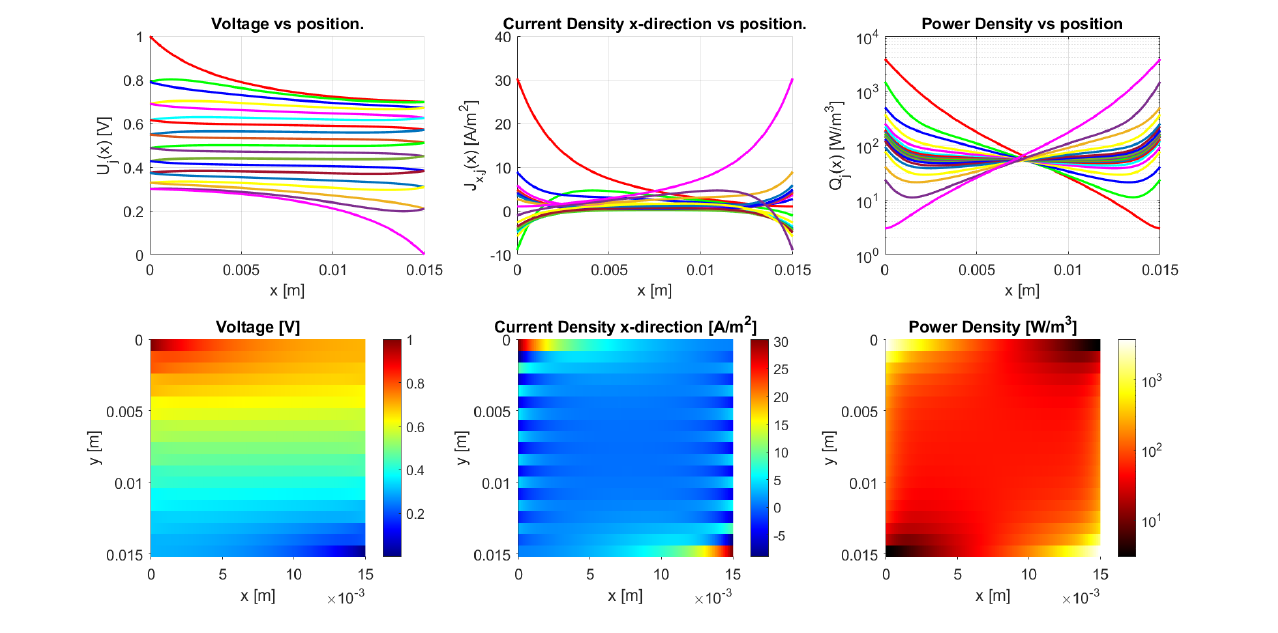
Figure 21. Model results for a meandering sample with the parameters from Table 2 and an inter-traxel resistance of σ = 2 × 10 − 2 Ω m 2 . This gives an anisotropy ratio of 0.100, showing mixed